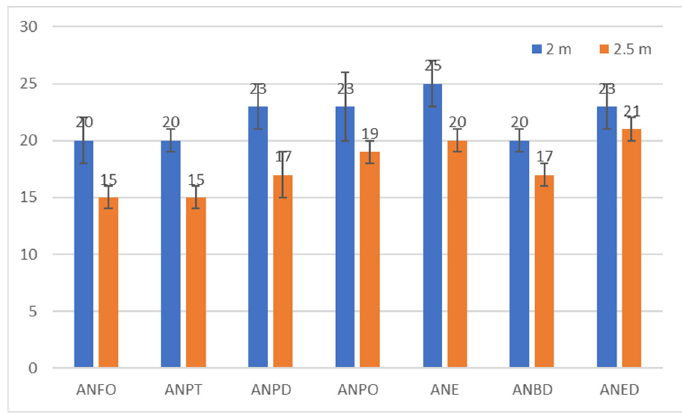
Figure 9. Dependence of the specific impulse on the type of organic fuel.